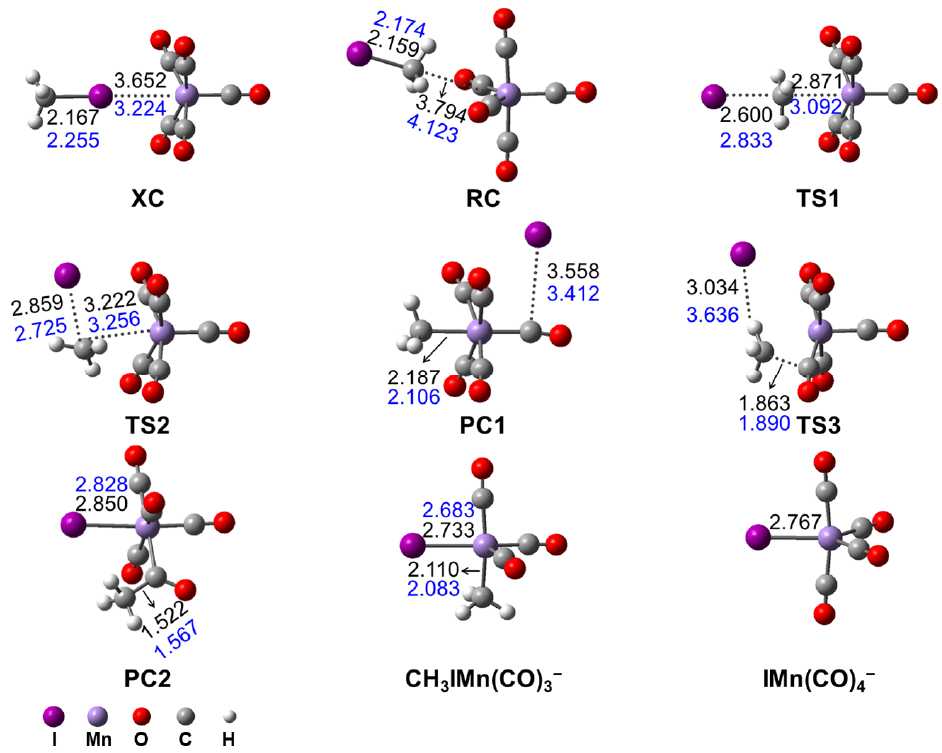
Figure 3. Structures of selected stationary points on the PES of Mn(CO) 5 − reacting with CH 3 I. The bond distances (Å) in black are for CH 3 I, and those in blue are for CF 3 I.